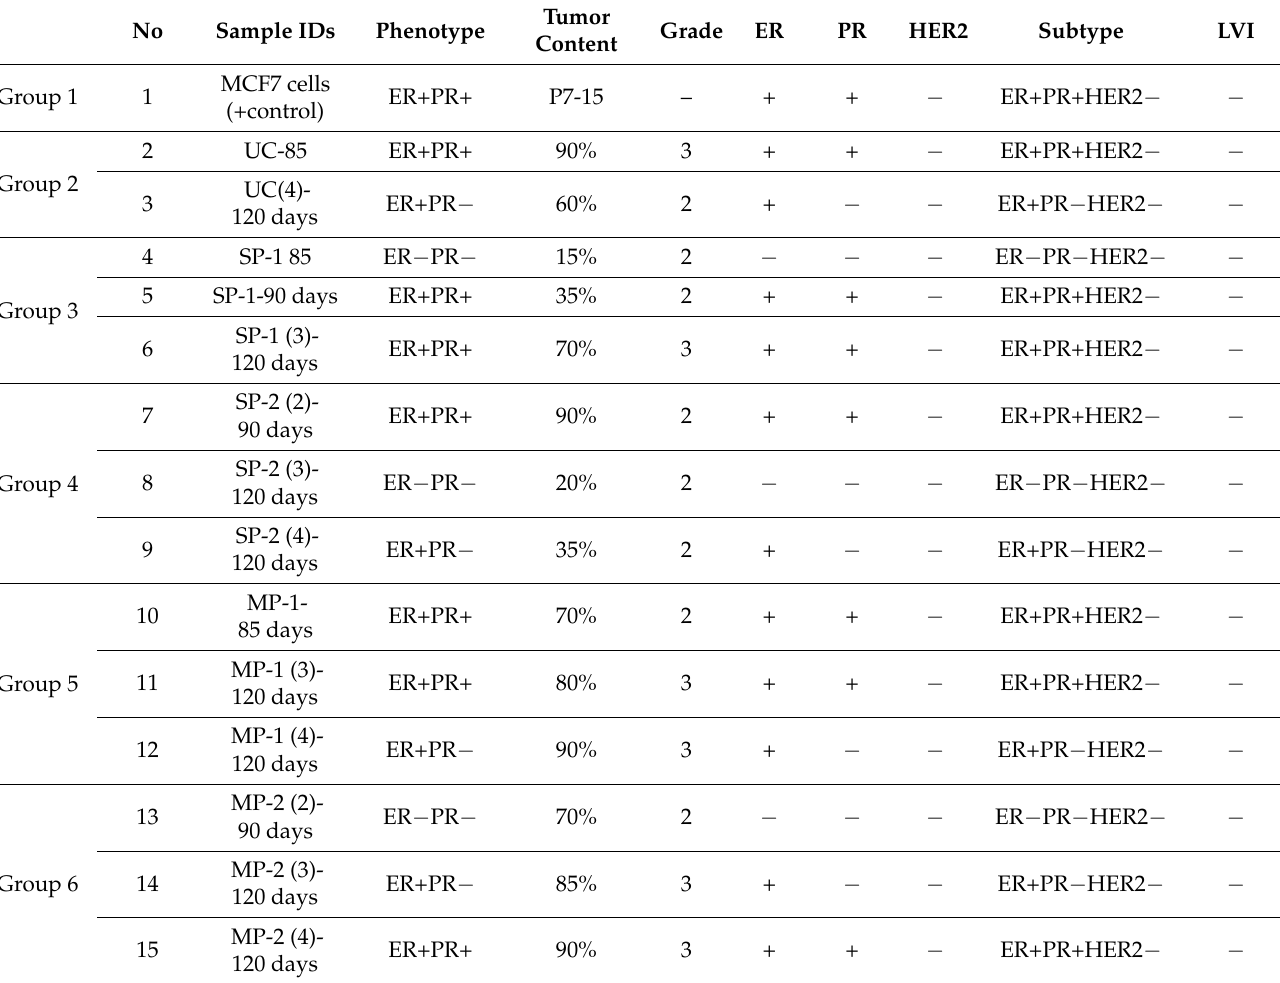
Table 1. Multiple breast tumor variants in xenografts generated from sorted fractions of MCF7 cell lines. Abbreviations: LVI—lymphovascular invasion; ER—estrogen receptor; PR—progesterone